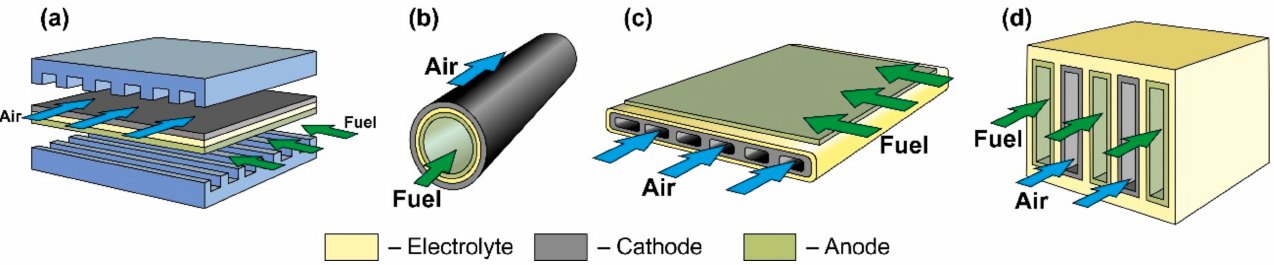
Figure 5. Schematics of ( a ) planar, ( b ) tubular, ( c ) flat-tube, and ( d ) monolithic